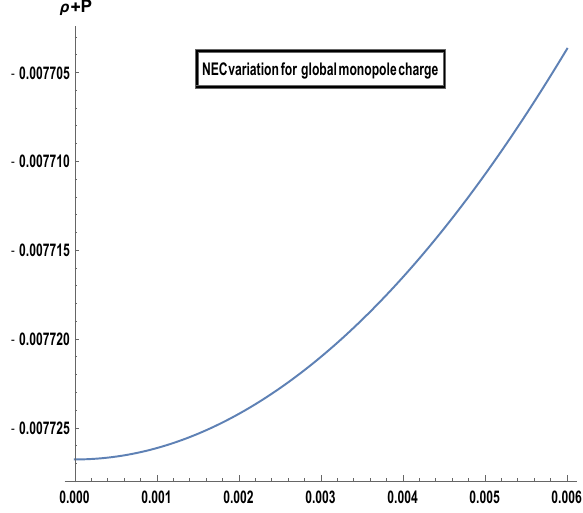
Fig. 17 Variation of NEC due to Global monopole charge, r = 1 . 8